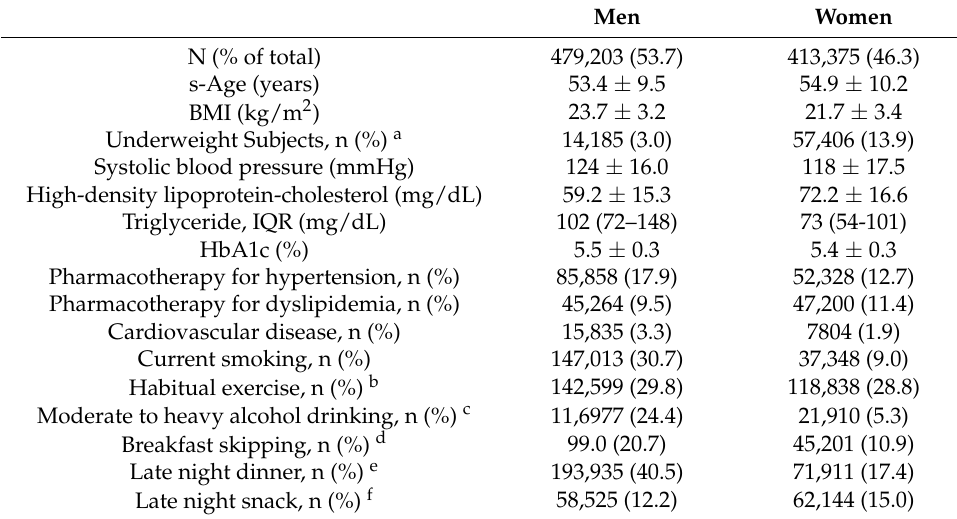
Table 1. Characteristics of subjects.